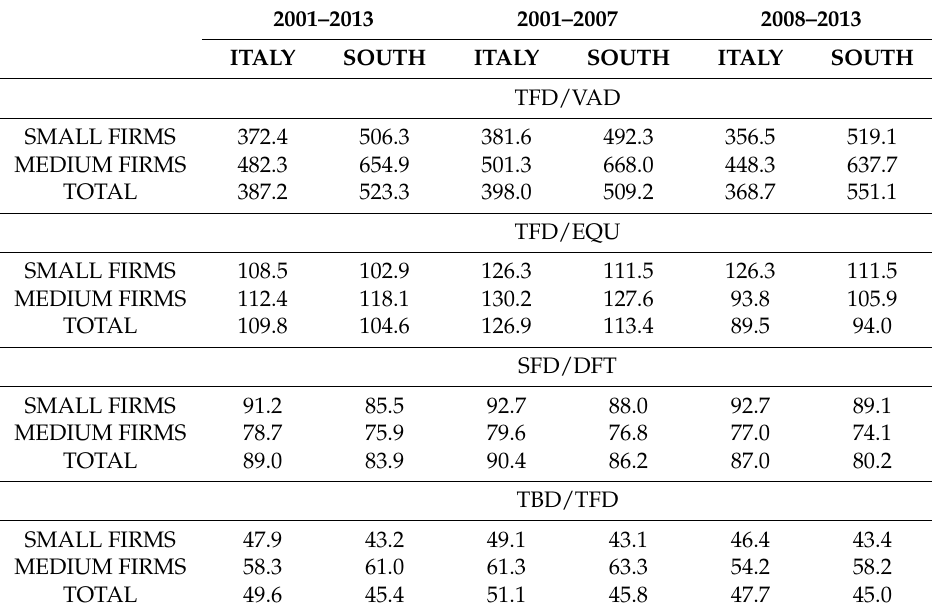
Table 3. Debt ratios for sized classes (median